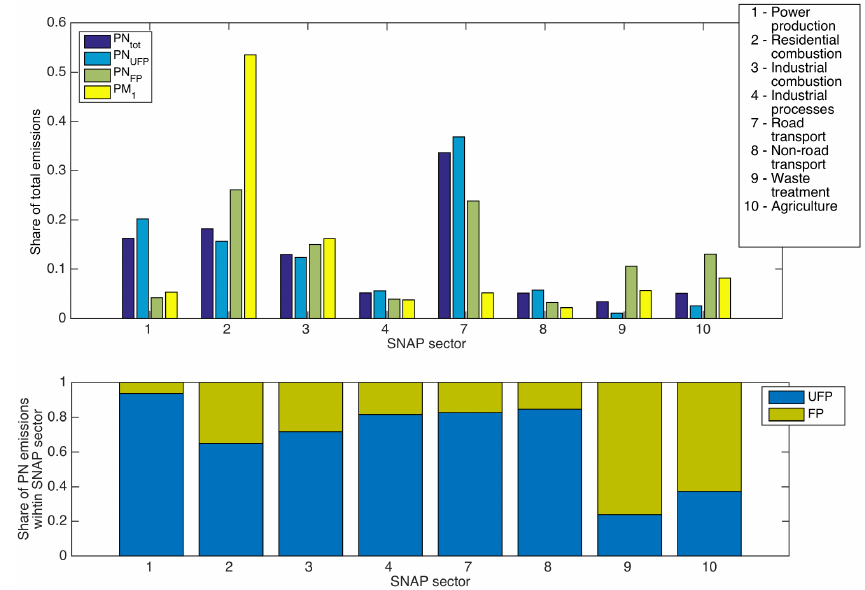
Figure 2. Upper panel: shares of different source sectors in number emissions of all (PN tot ) , ultrafine (PN UFP ) and fine (PN FP ) particles and in aerosol mass emissions of particles with diameters below 1µm (PM 1 ) for 2010. Lower panel: shares of UFP and FP in PN emissions for each